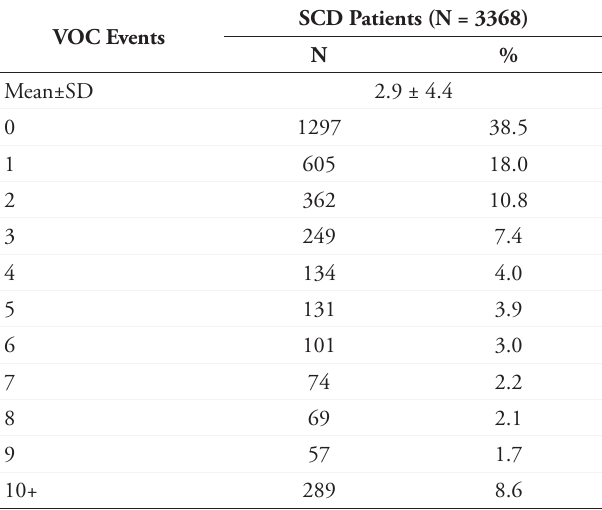
Table 2. VOC Events among Patients with SCD (N = 3368) VOC Events